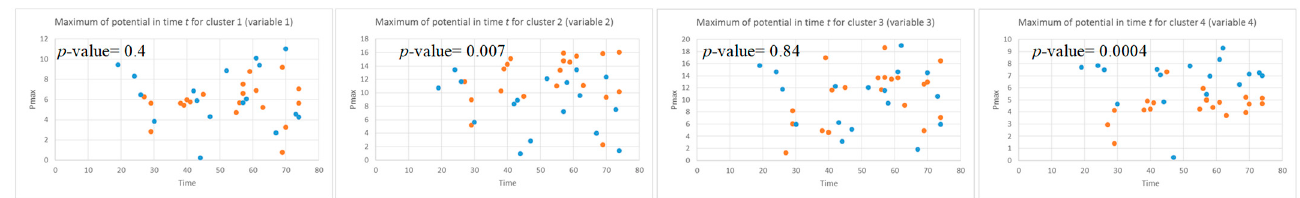
Figure 8. The dynamic patterns of the mean of PSP rates (an example of four clusters corresponding to Fp1, Fp2, F7, and F3 variables) during the learning process with EEG samples from the control class (in red) and OP class (in blue).